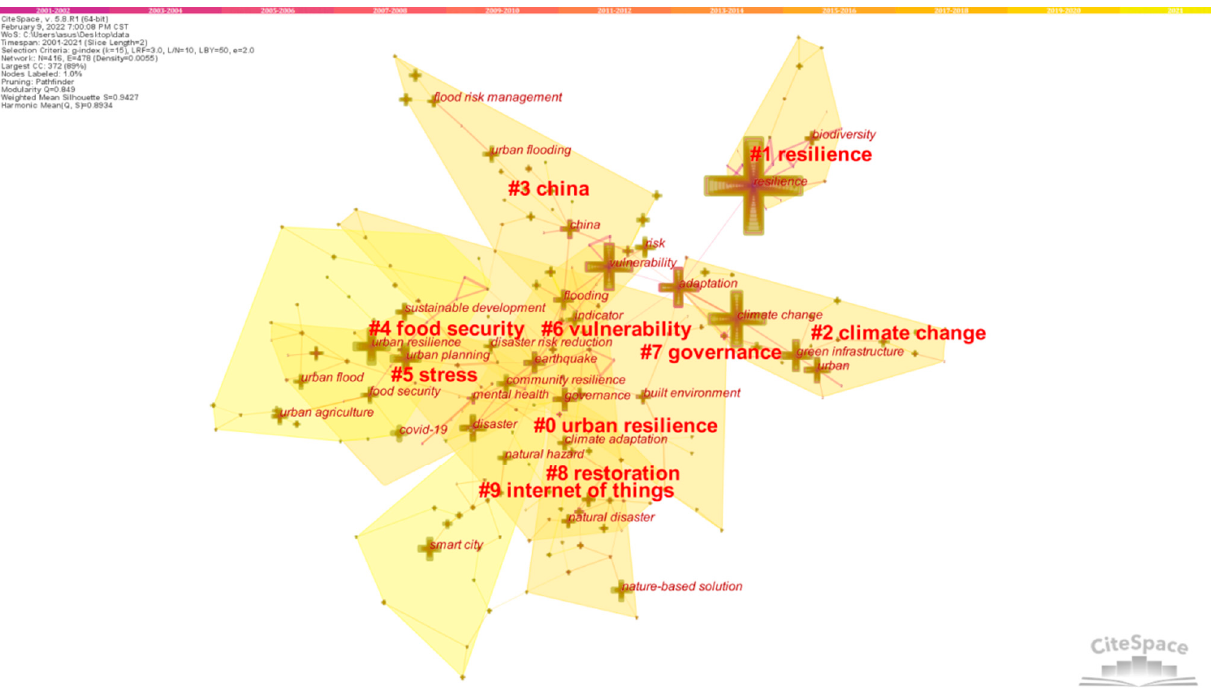
Figure 8. Cluster co-occurrence map for RC keywords.